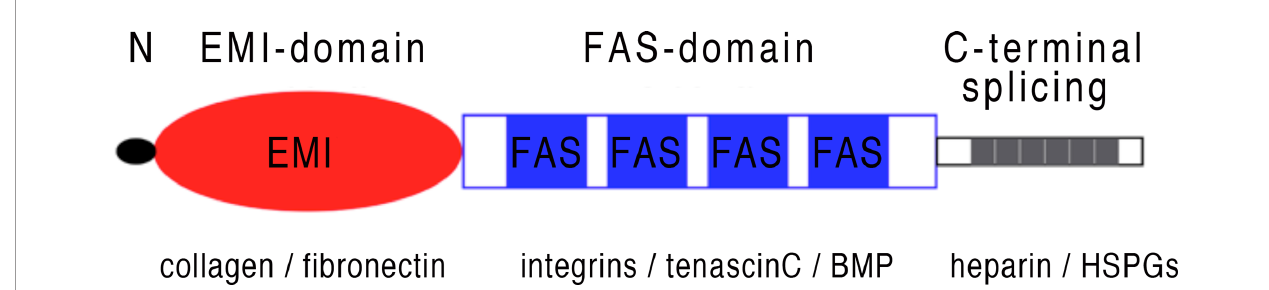
FIGURE 1 | Periostin schematic structure: Periostin is a secretory protein with a multi-domain structure, consisting of a secretion signal peptide, a N-terminal cysteine-rich EMI domain, four internal FAS domains and a C-terminal hydrophilic domain that can be alternatively spliced. The EMI domain interacts with collagen and fi bronectin, while the FAS domains can bind to integrins, tenascin-C and BMP. The C-terminal domain shows a high degree of alternative splicing, see also Figure 3 and can bind to heparin and HSPGs.